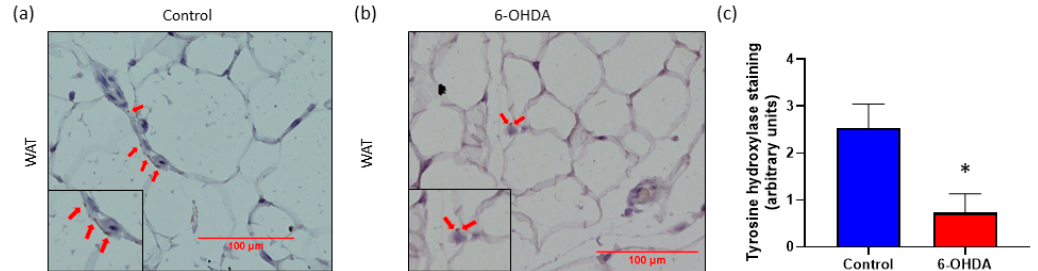
Figure 2. Chemical denervation with 6-OHDA significantly reduces sympathetic nervous system (SNS) innervation in white adipose tissue (WAT). ( a , b ) Representative immunohistochemistry images of tyrosine hydroxylase expression in WAT. Tyrosine hydroxylase (TH) staining is brown in color and is indicated with arrows. Insets indicate close-ups of TH staining. Size bar = 100 μ m. Magnification 200×. ( c ) Quantitation of tyrosine hydroxylase expression in WAT from BPH/2J mice, n = 3–5 mice/group. * p < 0.05; all data are presented as mean ± SEM.